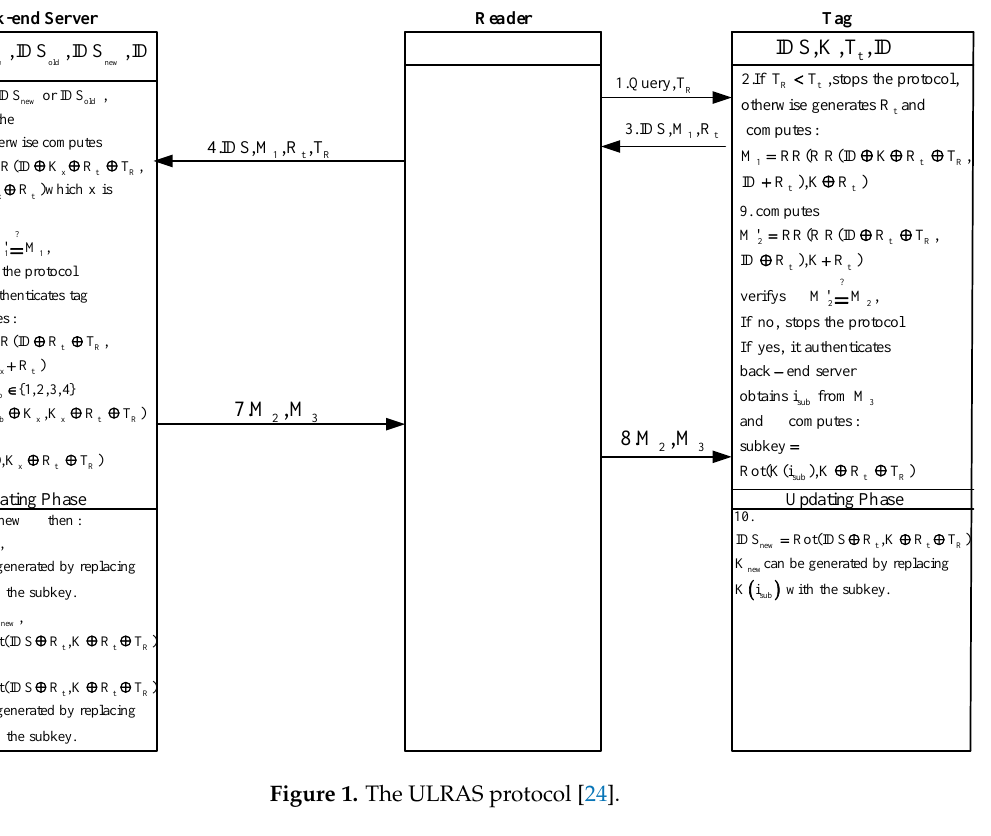
Figure 1. The ULRAS protocol [24].